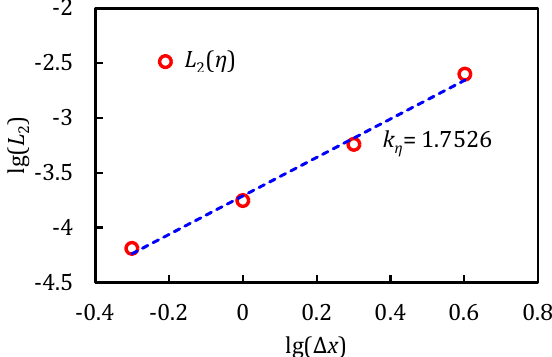
Figure 4. L2 error norms in η as function of ∆ x for solitary wave propagation in constant